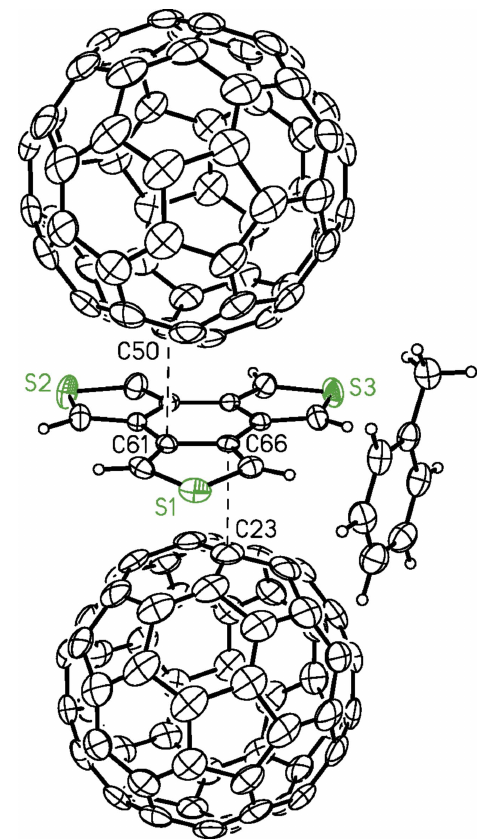
Figure 3 BTT- D 3h ‘squeezed’ between two C 60 molecules in D 3h -BTT (cid:2) C 60 (cid:2) toluene. The minor disordered fullerene moiety is omitted for